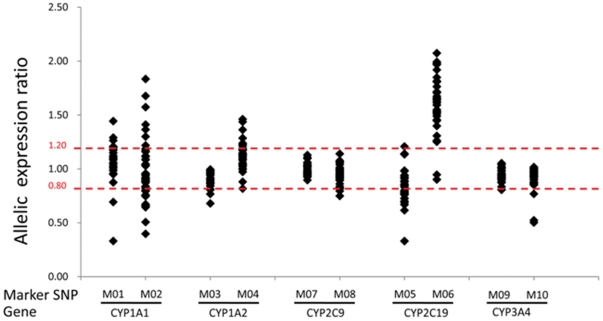
Distribution of allelic expression ratios of five P450 genes.M01 to M10 denotes markers SNP 1 to 10, which are rs1048943, rs4646421, rs17861162, rs762551, rs4388808, rs4244285, rs1934967, rs1934969, rs2246709 and rs33972239, respectively, in CYP1A1, CYP1A2, CYP2C19, CYP2C9 and CYP3A4. The marker SNP is either intronic or exonic, and the ratio of two alleles of marker SNP in the cDNA is representative of the allelic expression ratio of the corresponding gene. The upper and lower dashed lines indicate AERs of 1.2 and 0.8, respectively. In general, an AER of less than 0.8 or greater than 1.2 is experientially indicative of allelic expression imbalance.